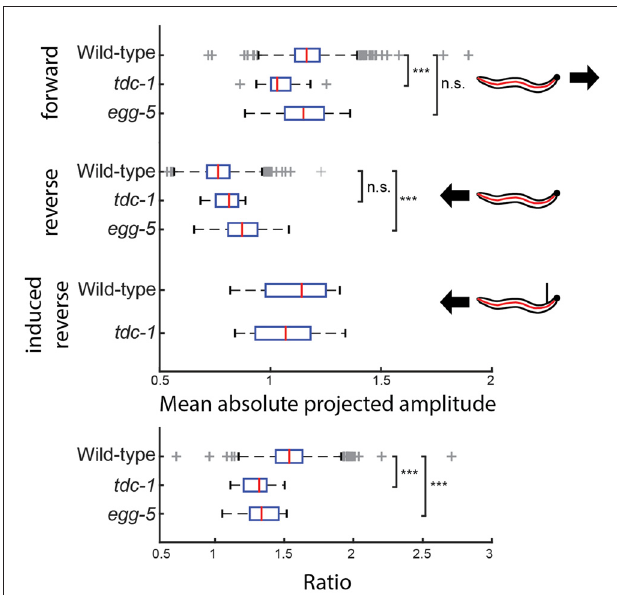
FIGURE 7 | The amplitude of the jPCA anterior oscillation is measured for individual worms of three different genotypes during forward locomotion and reversals. (wild type N2: n = 1303, tdc-1 : n = 19, egg-5 : n = 23) tdc-1 has significantly reduced head oscillation during forward locomotion, but suppresses it during reversals to the same magnitude as wild types ( p adj ( tdc-1 ) = 4.80 × 10 − 5 ), while the opposite can be observed in egg-5 mutants ( p adj ( egg-5 ) = 3.71 × 10 − 4 ). During touch-evoked reversals, head oscillation is reduced in both wild type N2 and tdc-1 worms. Both have a significantly smaller ratio (forward/spontaneous reversal) than wild type ( p adj ( tdc-1 ) = 3.73 × 10 − 6 , p adj ( egg-5 ) = 6.69 × 10 − 6 ). ∗∗∗ Indicates p <